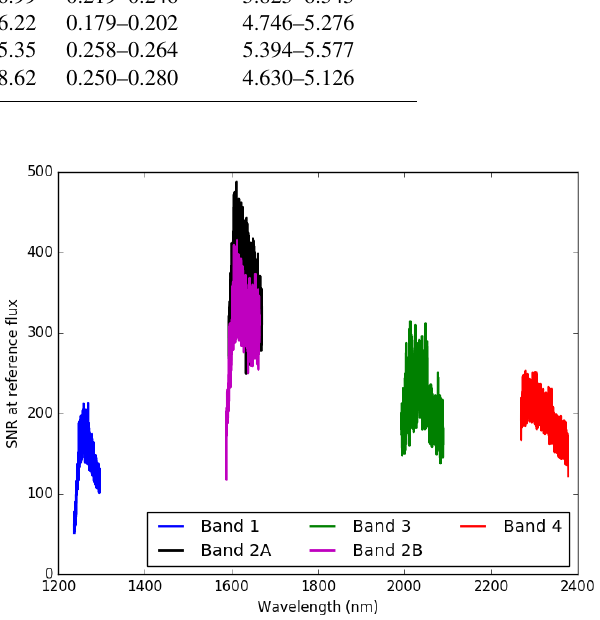
Figure 16. Estimate of GHOST SNR for each band derived from integrating sphere measurements, assuming radiances typical of Global Hawk flight observations (Table 6). See text in Sect. 3.6 for